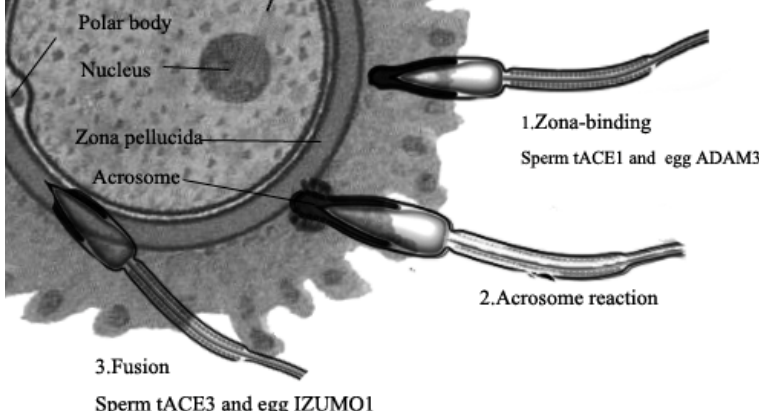
Figure 2. Mechanisms of sperm–egg interaction. tACE1 and ADAM3 are dispensable factors for the binding of sperm to the zona pellucida, whereas tACE3 and IZUMO1 play important roles in the fusion of gametes to sperm. ADAM: a disintegrin and metalloprotease; ZP: zona pellucida; tACE1: testis angiotensin-converting enzyme 1; tACE3: testis angiotensin-converting enzyme